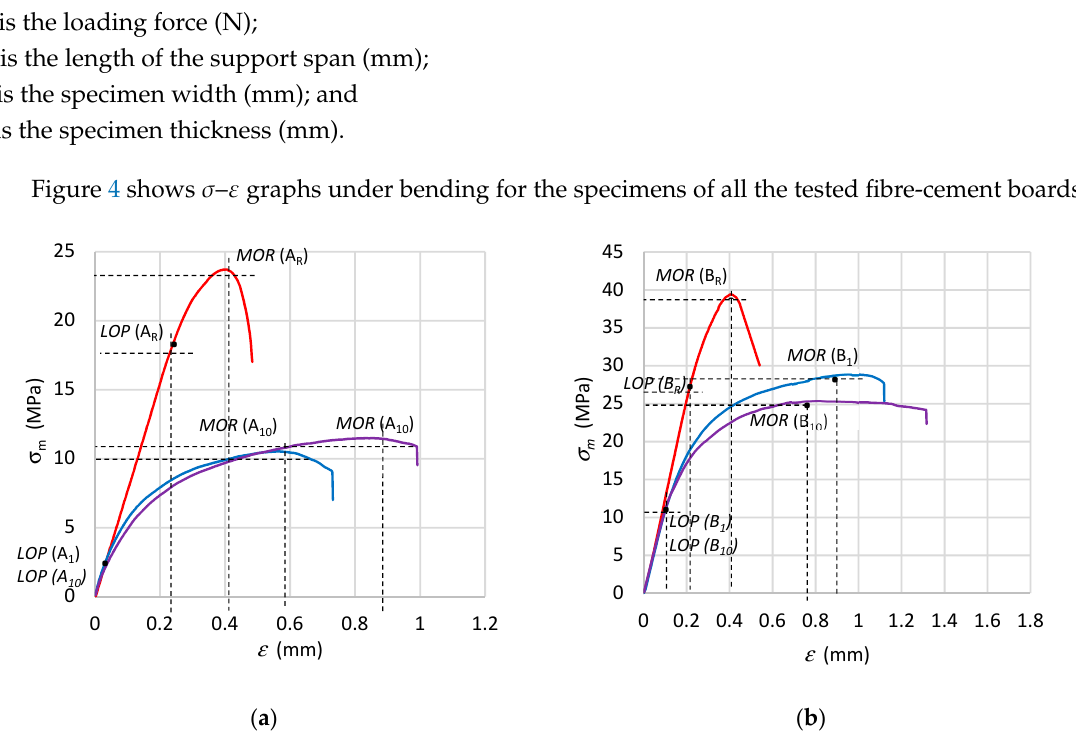
Figure 4. Bending σ – ε relation for specimens of fibre-cement boards: ( a ) series A, ( b ) series B. LOP : limit of proportionality; MOR : modulus of rupture.